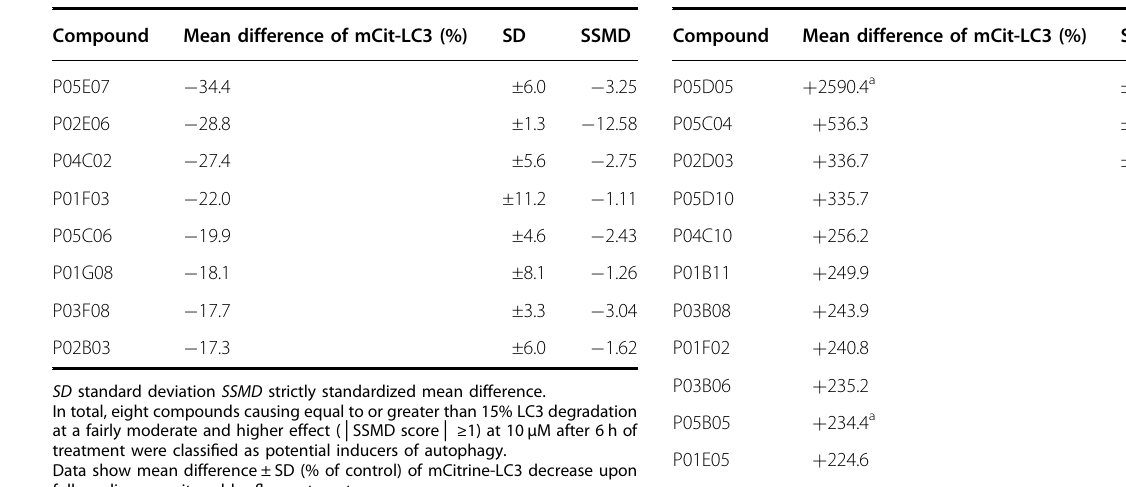
Table 1 List of potential autophagy